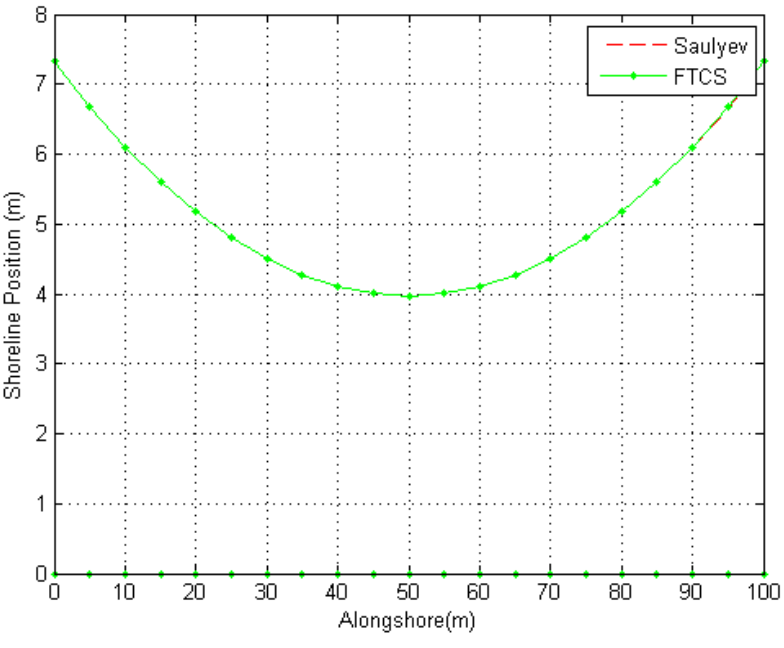
Figure 6. Shoreline evolution in one year. Table 5. Approximated shoreline evolution along one year by a traditional forward time-centered space technique.